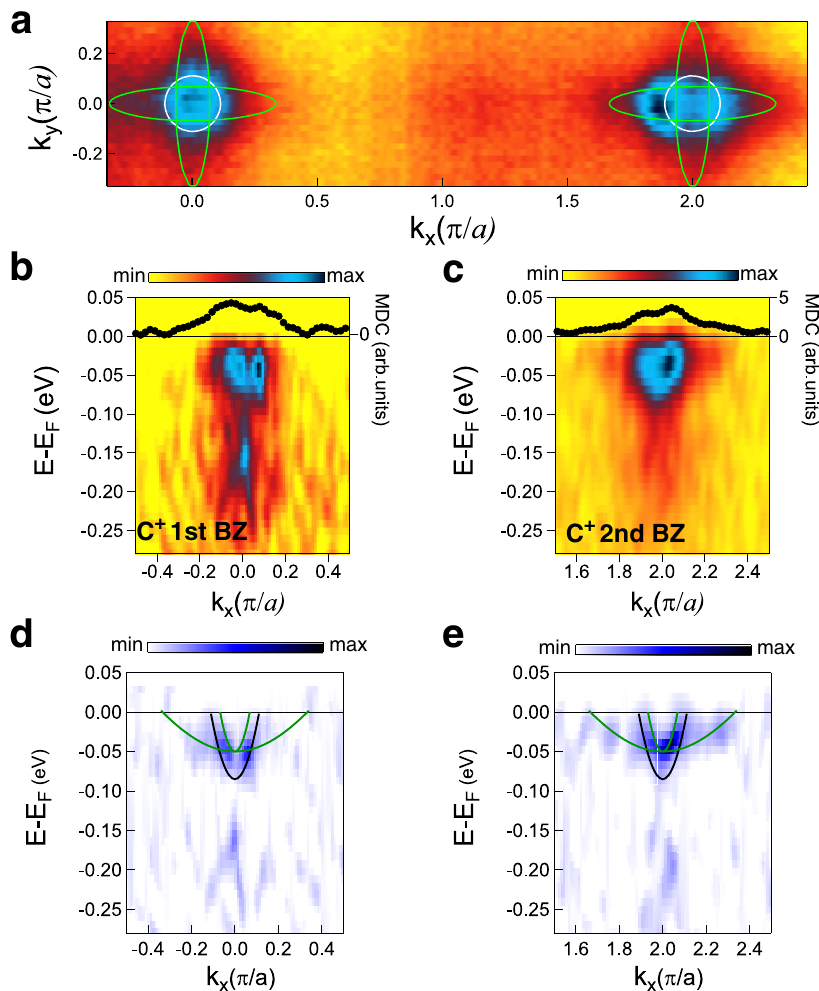
Fig. 4 Resonant angle-resolved photoemission spectra. a Average between circular plus and circular minus Fermi surface map of the (001) LAO/ETO/STO heterostructure. Dashed lines are Fermi surface contours of light (white) and heavy (green) bands. b , c E vs. k x band dispersions maps acquired with C + polarization in the 1 st and 2 nd BZ. Black scatter data on top of each band dispersion map are the Fermi level MDCs curves (integrated around E F in a 10 meV range). All the data are measured in resonance conditions (465.5 eV). d , e two-dimensional curvature maps of the C + dispersions in b and c , with tight-binding fi tting of the bands (green lines 3d xz and 3d yz bands, black line 3d xy